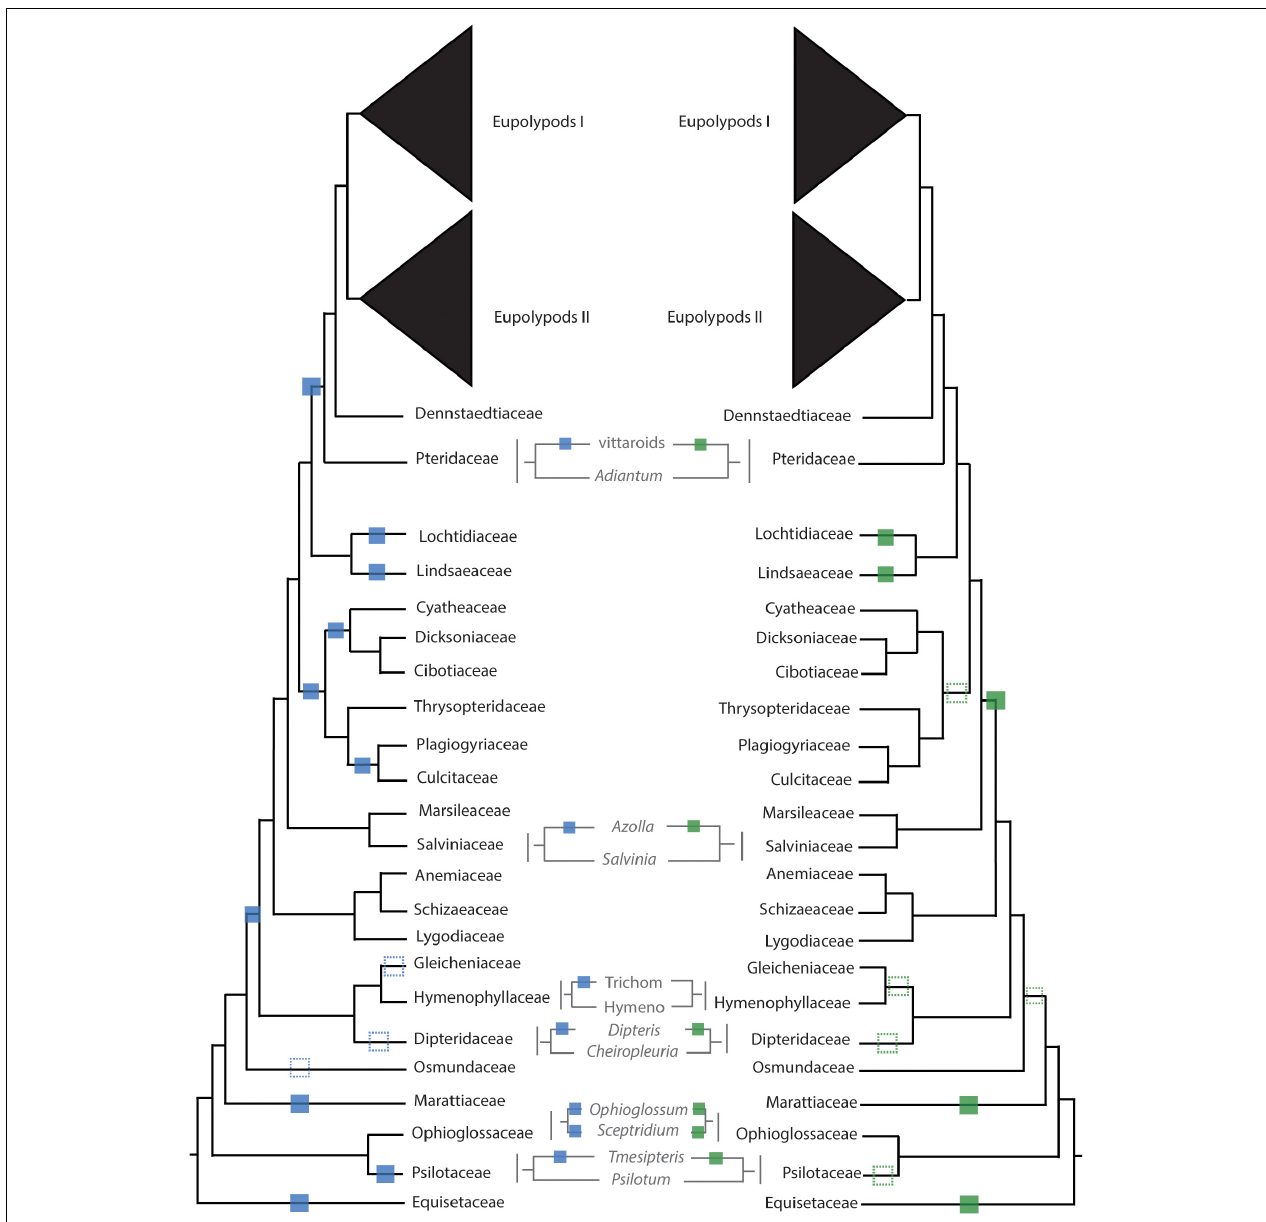
FIGURE 4 | Inferred whole genome duplication (WGD) events from uncorrected (left, blue) and corrected (right, green) K S analyses. Unambiguous placements of inferred WGDs are depicted as solid squares; ambiguous placements are depicted as dotted squares. Trichom = Trichomanoideae, Hymeno = Hymenophylloideae.